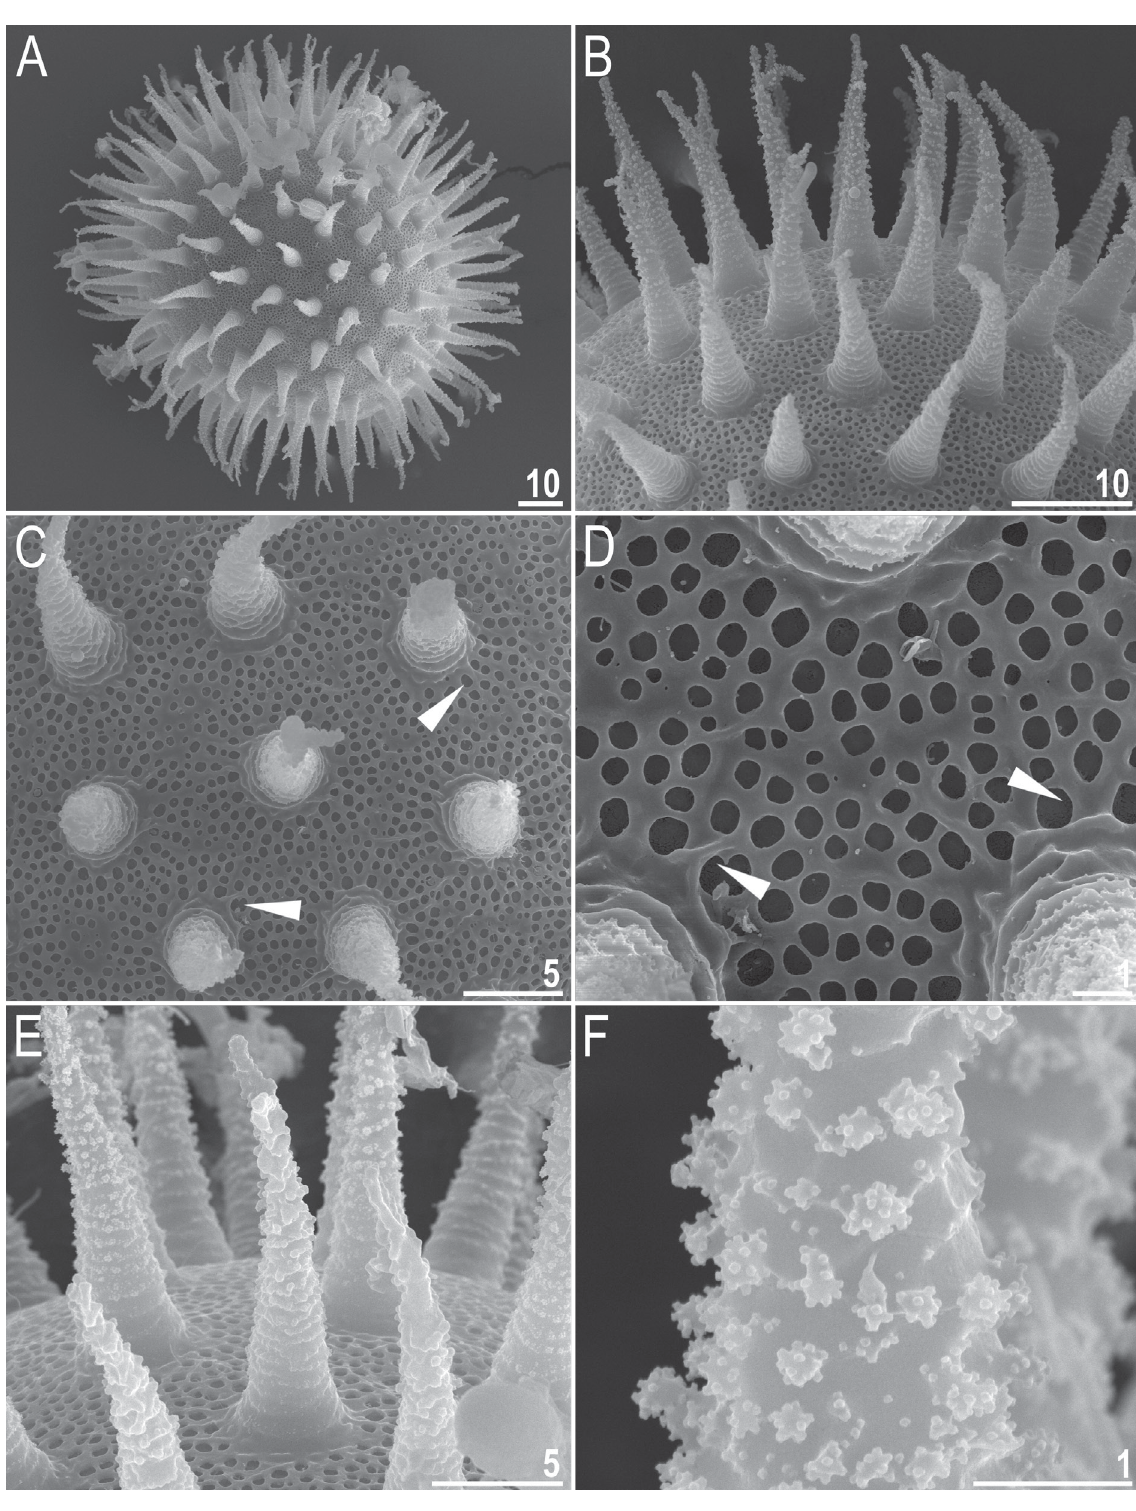
Fig. 14. Macrobiotus cf. recens Cuénot, 1932 , Gran Canaria, egg chorion morphology seen under SEM. A . Entire egg. B . Close up of the egg surface and processes. C–D . Details of the egg surface. E–F . Details of process morphology. Filled arrowheads indicate short thickenings radiating from the process bases. Scale bars in